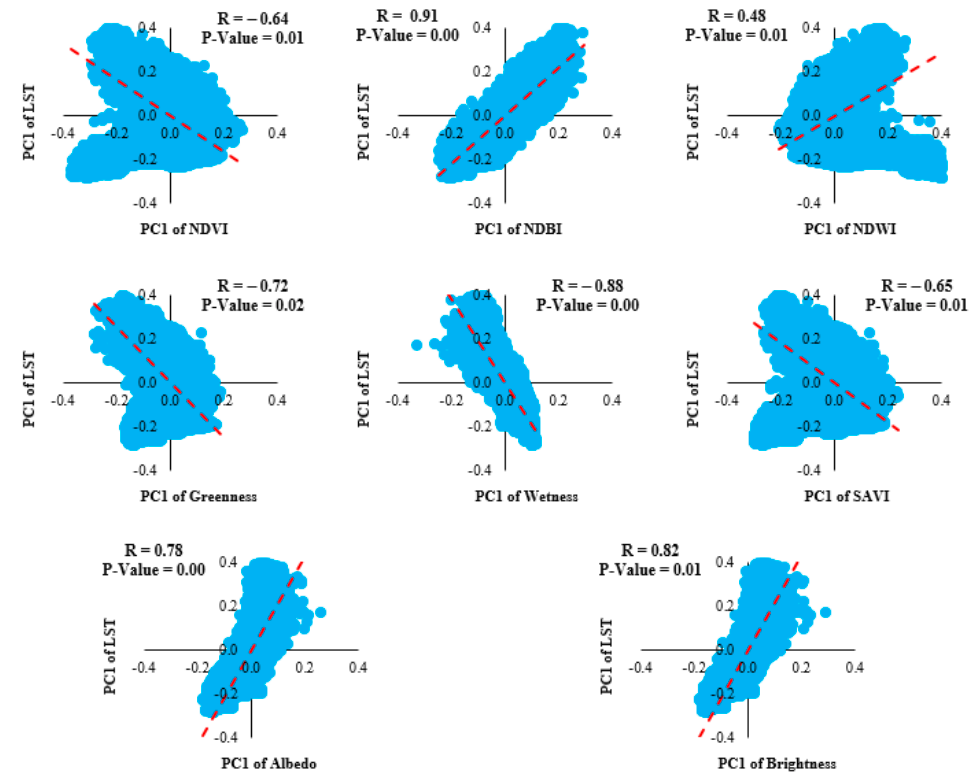
Figure 9. Relationship between the PC1 of LST and the PC1 of each surface biophysical parameters using OLS regression with a regional approach.